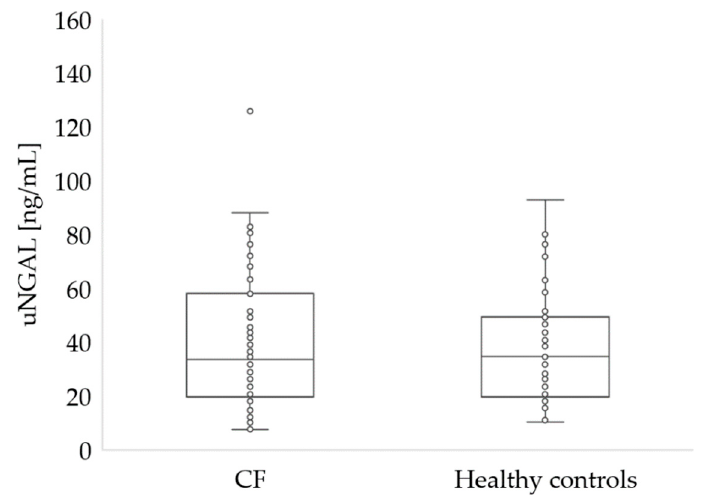
Figure 3. Urine NGAL concentration in patients with CF and healthy controls ( p > 0.05).